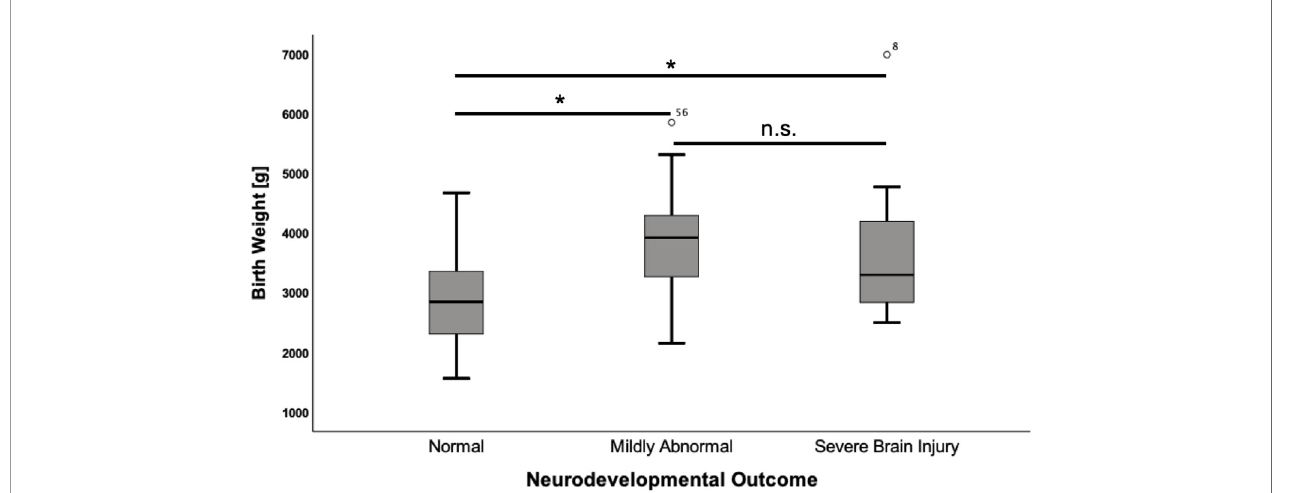
FIGURE 1 | Birth weight according to neurodevelopmental outcome. Values are displayed as mean ± standard deviation. ANOVA with Tukey post hoc comparison showed signi fi cant differences in the mean for normal neurodevelopmental outcome (n = 50) vs. mildly abnormal development (n = 14) (2,892 ± 779 vs. 3,940 ± 1,013, p = <0.001) and normal neurodevelopmental outcome vs. severe brain injury (n = 13) (2,892 ± 779 vs. 3,720 ± 1,220, p = 0.012). *p = < 0.05. n.s., not signi fi cant.